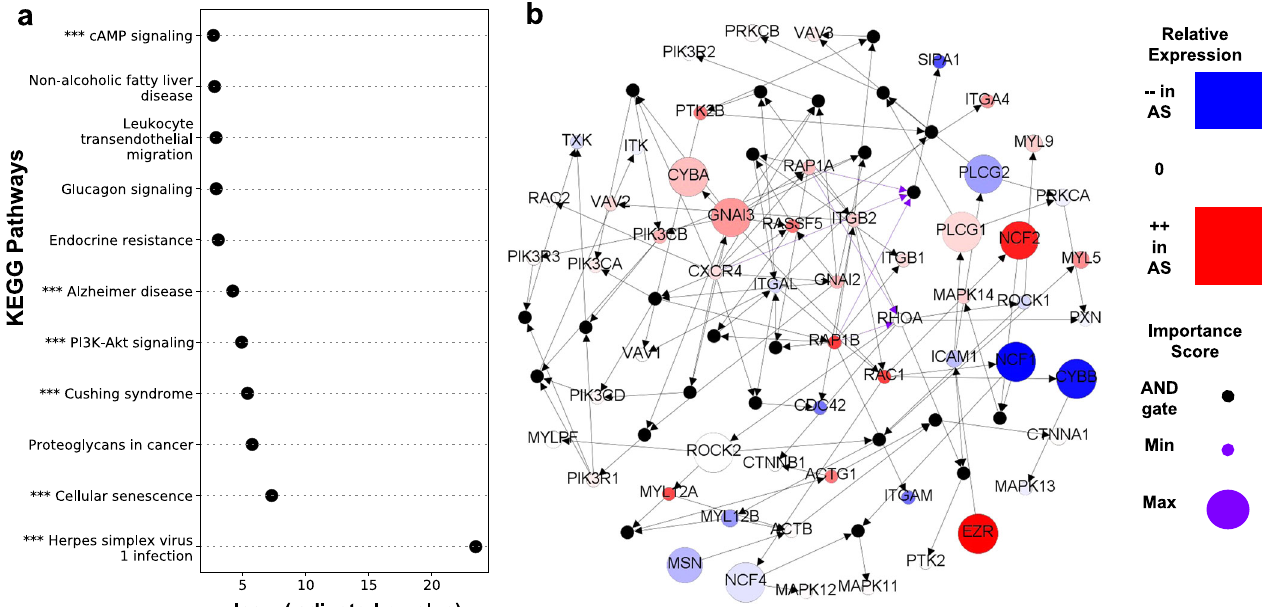
Fig. 4 scBONITA identi fi es dysregulated pathways in monocytes derived from AS + and AS − PLWH. a Pathways ( y -axis) dysregulated in the AS + vs. AS − contrast in monocytes derived from PLWH. Only pathways that have Bonferroni-corrected p -value < 0.01 ( x -axis) and reduced ERS (see Methods for details) are shown. Pathways labeled with “ *** ” were also signi fi cantly dysregulated in monocytes after one year of HIV infection 38 b Network representation of the leukocyte transendothelial migration pathway. Small black intermediate nodes indicate that the downstream nodes are controlled by an AND function of the upstream nodes. The size of nodes corresponding to genes is proportional to their importance score as calculated by scBONITA. Nodes are colored according to the magnitude of their fold change between the HIV + AS + and HIV + AS − groups. Violet edges indicate inhibition edges and black edges indicate activation